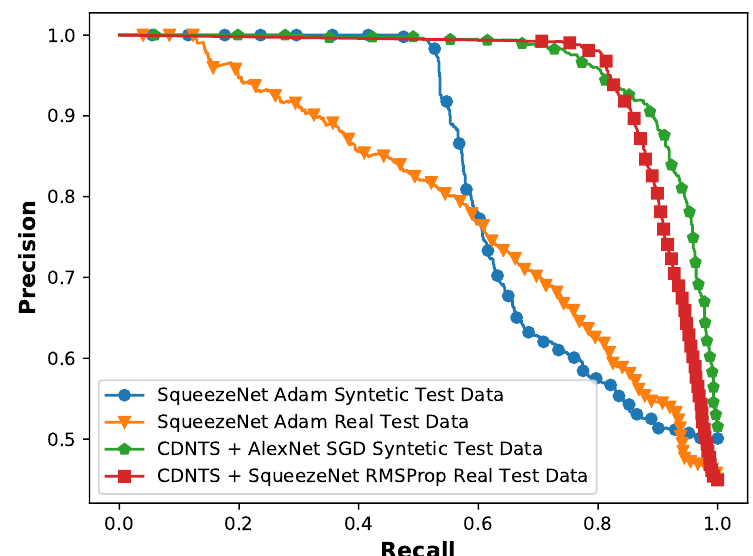
Figure 9. Experiments 1 and 2: the precision and recall graph of the most successful networks of syntetic image test of squeezeNet with Adam optimizer (blue), real image test of SqueezeNet with Adam optimizer (orange), synthetic image test of CDNTS +AlexNet with SGD optimizer (green), real image test of CDNTS + SquezeeNet with RMSProp optimizer (red).